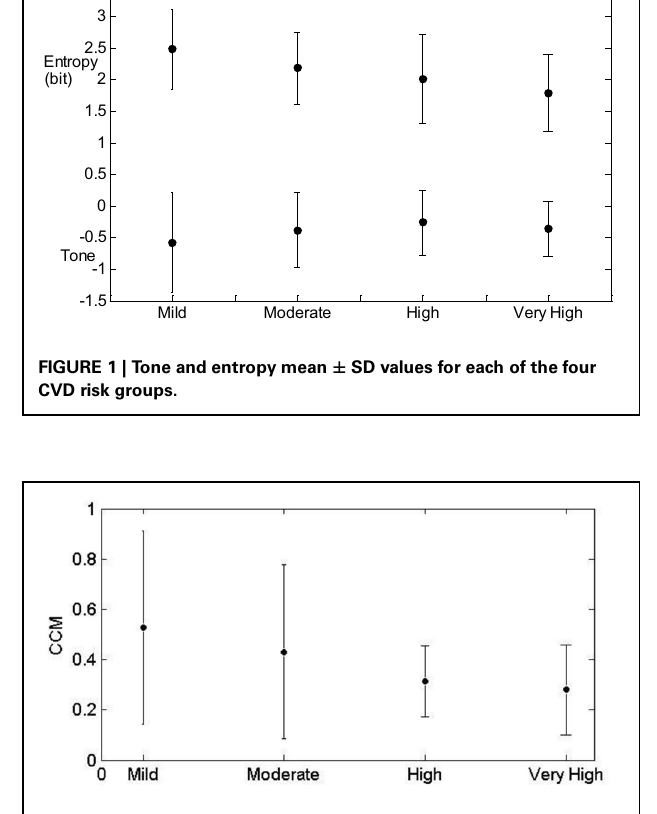
FIGURE 2 | CCM mean ± SD values for each of the four CVD risk groups.